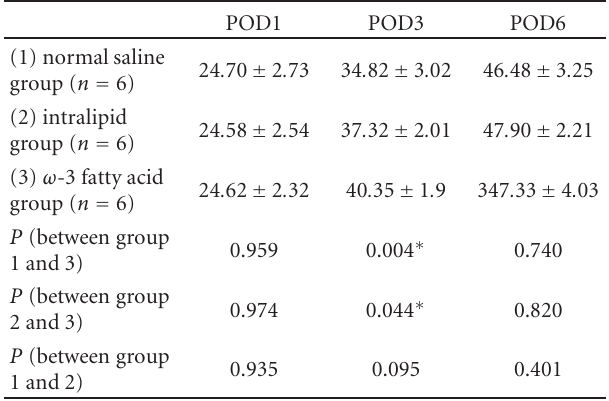
Table 1: Gastric emptying rate (%).